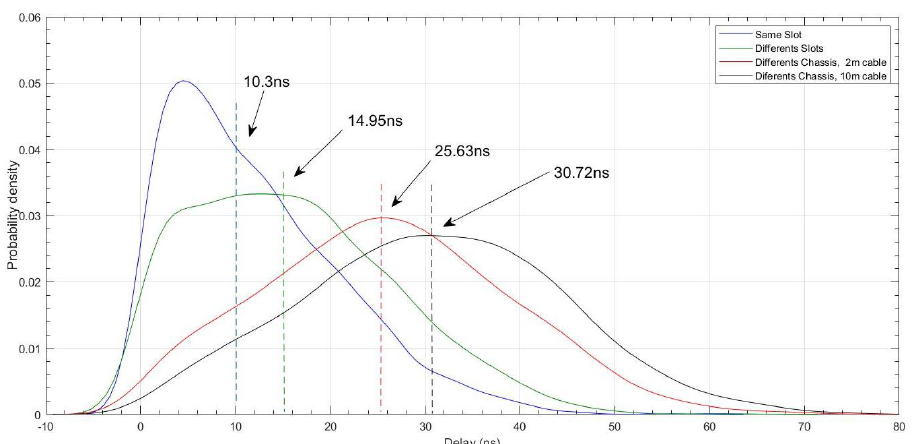
Figure 13. Probability density for SAR converters. Table 5. Comparison of uncertainty levels for Sigma-Delta and SAR